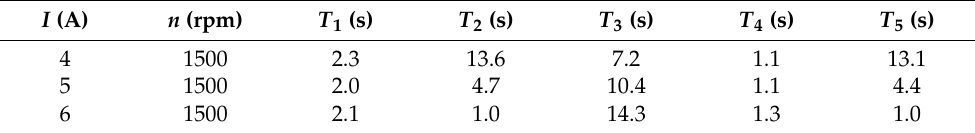
Table 7. Control time of the NiTi wire based actuator at various electric